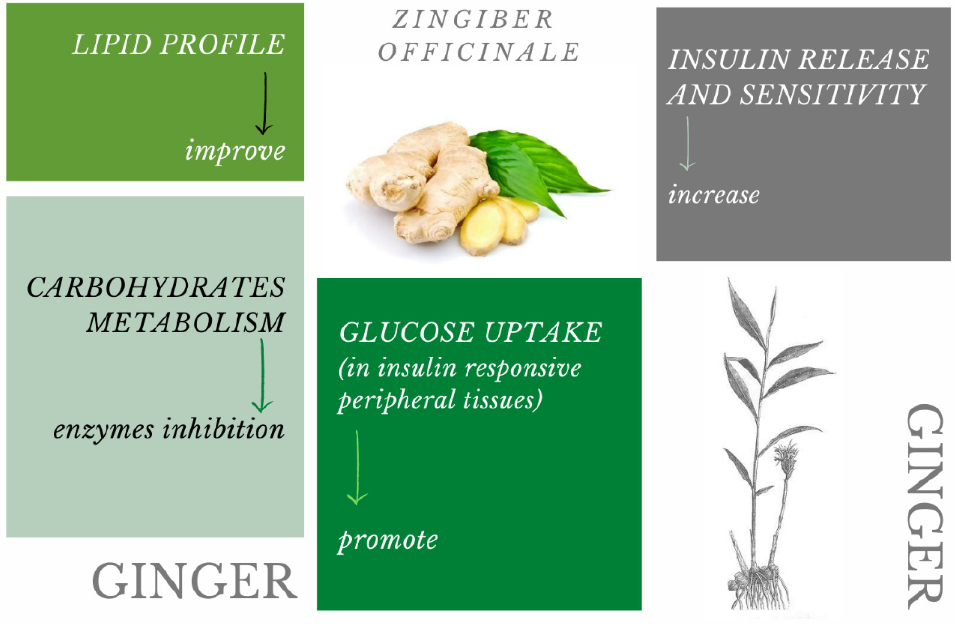
Figure 1. The ways in which the active ingredients in ginger affect glycaemic control